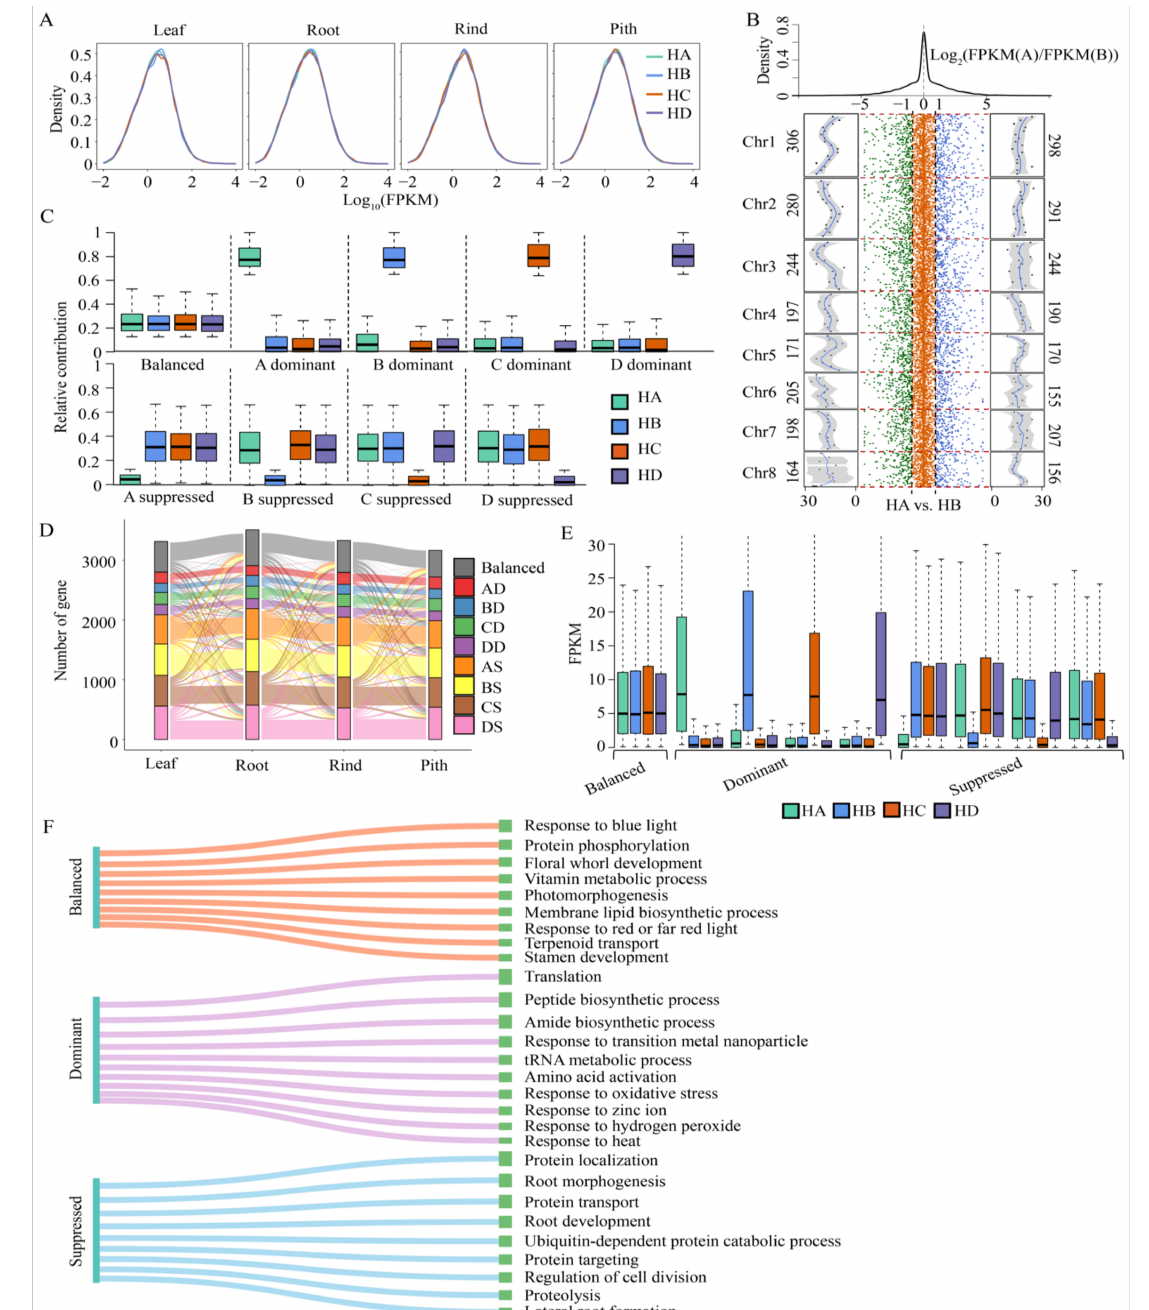
Figure 1. Expression patterns of homologous alleles in autopolyploid sugarcane. ( A ) Genome- wide gene expression distribution across different tissues of sugarcane. ( B ) Homologous alleles expression bias and location preference of comparison between HA an HB. ( C ) Nine expression categories of homologous tetrad alleles. ( D ) Proportion of nine expression categories across four tissues. ( E ) Comparison of expression level of tetrad alleles from nine categories. ( F ) Enriched GO functions of balanced, dominant and suppressed tetrad